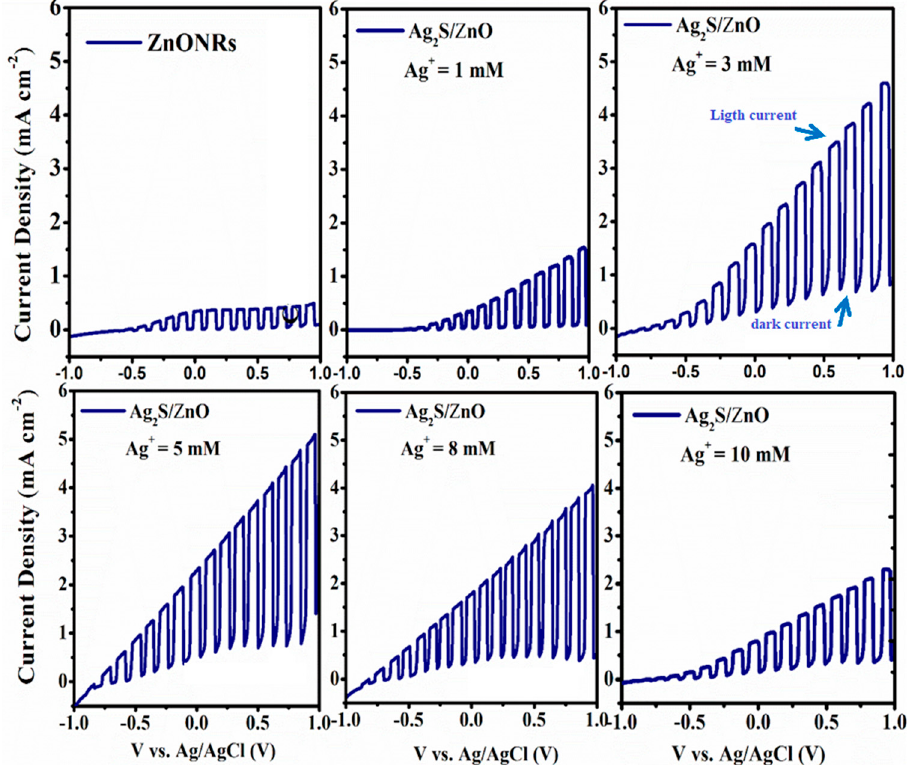
Figure 4. Linear sweep voltammograms from − 1.0 to 1.0 V at a scan rate of 20 mV s − 1 for ZnO NRs/ITO and Ag 2 S/ZnO NRs/ITO formed at various AgNO 3 concentrations.